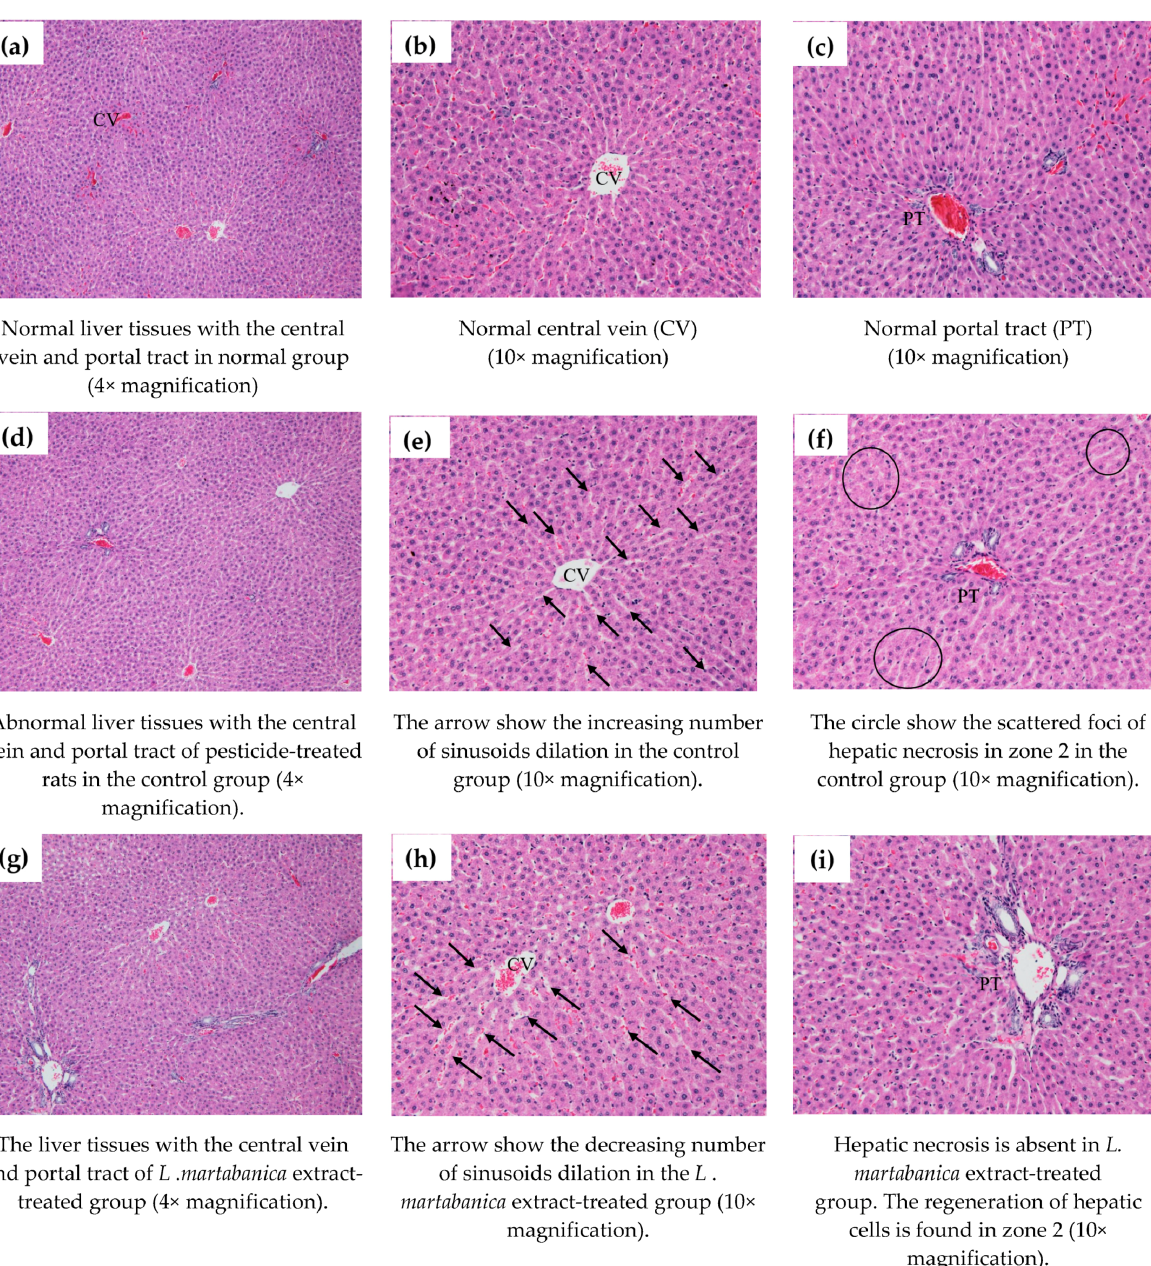
Figure 9. Histopathologic results of rat liver. ( a – c ): Histology results of the normal rat liver in the normal group. ( d – f ): His- tology results of the rat liver in the control group receiving chlorpyrifos. The picture shows the dilation of sinusoids (arrow) and the scattered foci of hepatic necrosis in zone 2 (circle). ( g – i ): Histology results of the group that received high doses of L. martabanica extract (750 and 250 mg/kg). The number of sinusoids dilation is